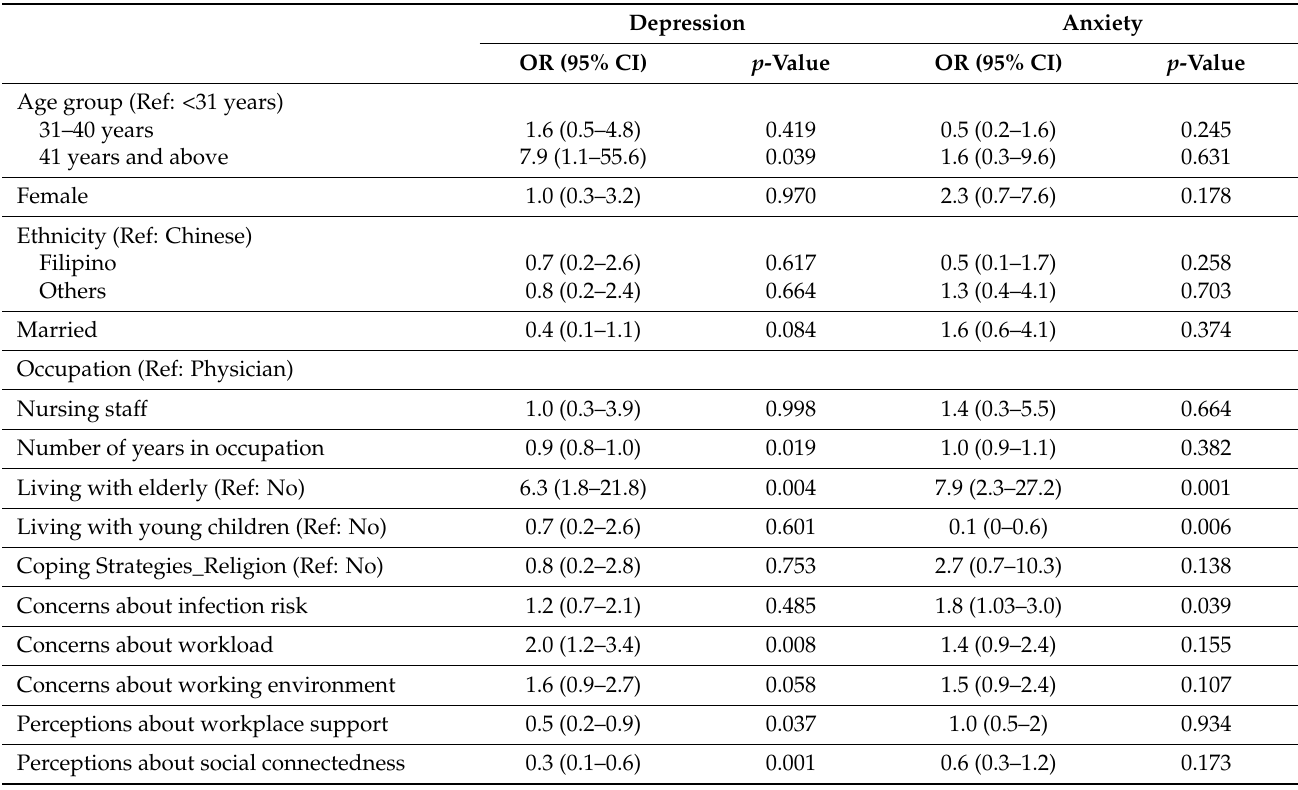
Table 4. The association between individual factors and each MHO (random-effects logistic